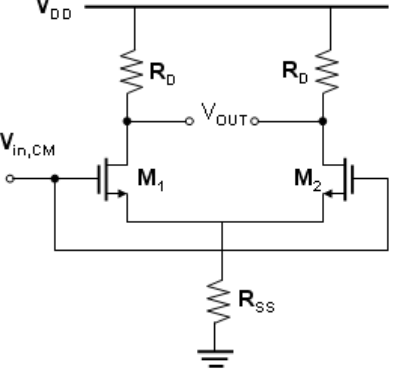
Figure 1. The schematic diagram of the typical common-mode differential